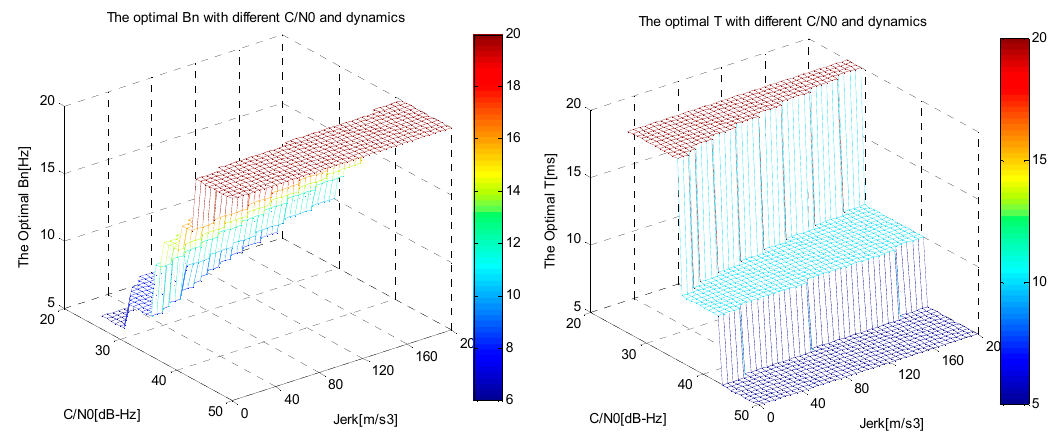
Figure 4. The minimum phase tracking error for different dynamics and C / N 0 .